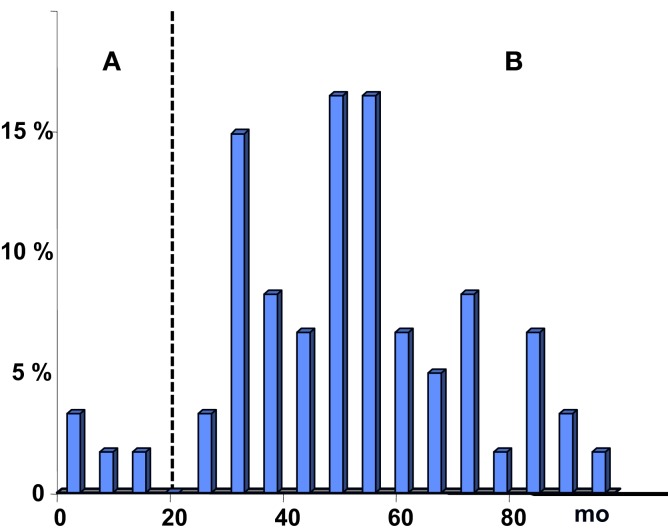
Histogram showing the distribution of patients, according to the delay elapsed from last injection of aluminum hydroxide-containing vaccine to muscle biopsy evidencing MMF lesions. For patients with a delay below 18 months (group A), it is not possible to consider MMF lesion as certainly pathological. In patients from group B, the delay is above 18 months indicating an abnormally protracted persistence time of aluminic granuloma.